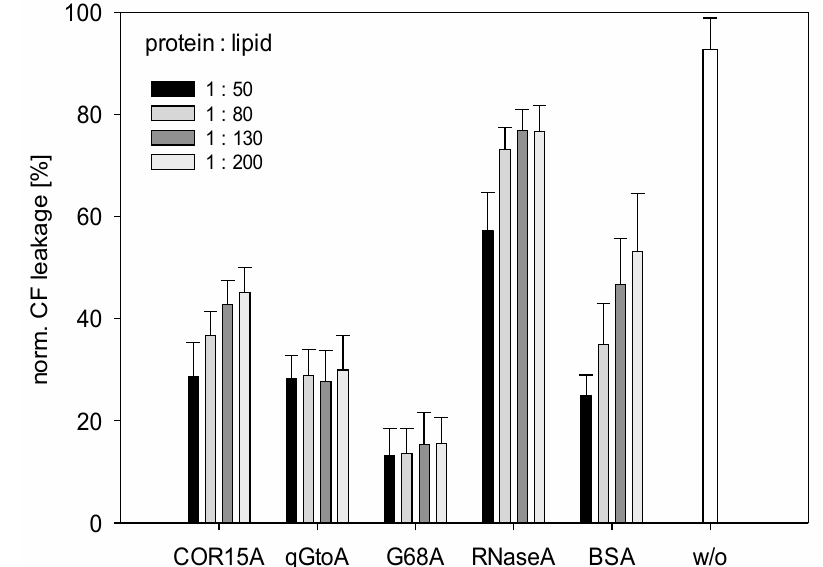
Figure 8. α -helical mutants reduce carboxy fluorescein (CF) leakage from vesicles. Carboxy flourescein leakage of inner chloroplast membranes (ICMM) large unilamellar vesicles (LUVs) after freezing and subsequent thawing was performed using the fluorescence signal detected by λ ex = 492nm and λ em = 517nm. The protein:lipid molar ratios used were 1:50, 1:80, 1:130, 1:200, and these are shown in different shades. All proteins showed a significance level p < 0.001 compared to ICMM LUVs without protein ( w / o ). Error bars refer to the standard derivation of triplicates from up to three experiments.